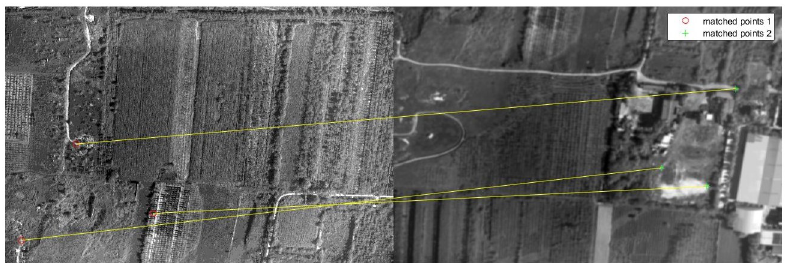
Fig 16. Matching results of aerial images with different sharpness by BRISK algorithm.